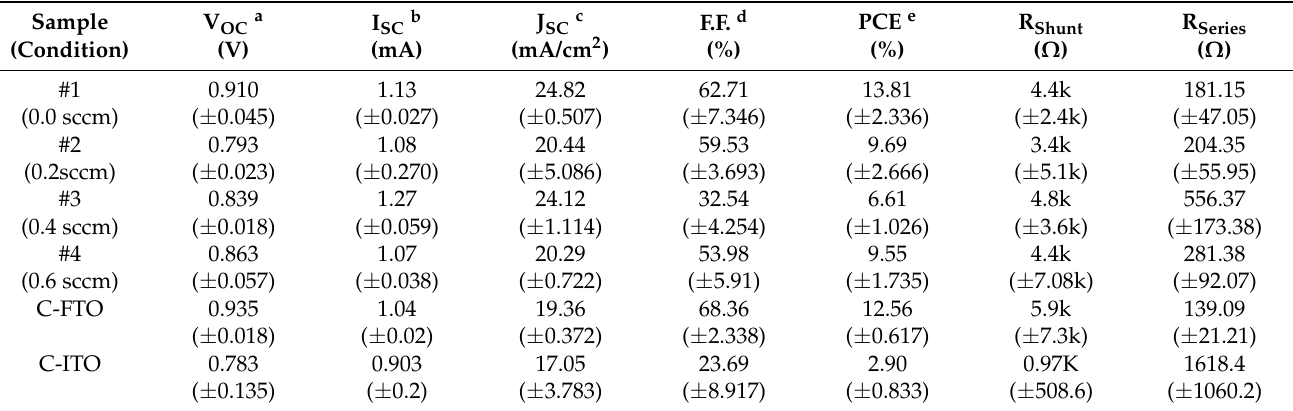
Table 3. Photovoltaic-performance parameters of PSCs with various TCO materials.